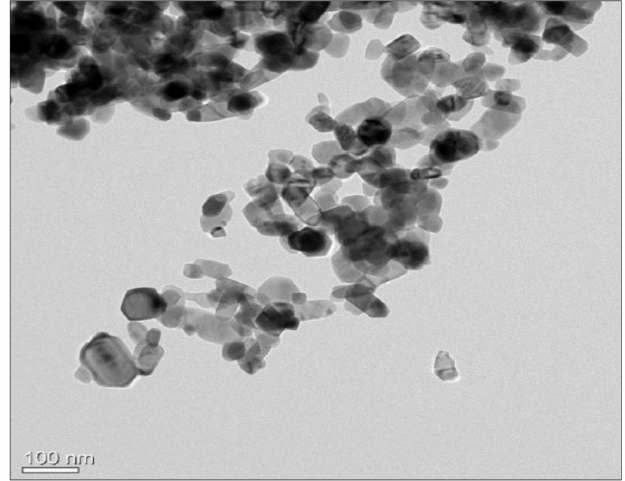
Figure 14. TEM image of the dried TiO 2 nanoparticle